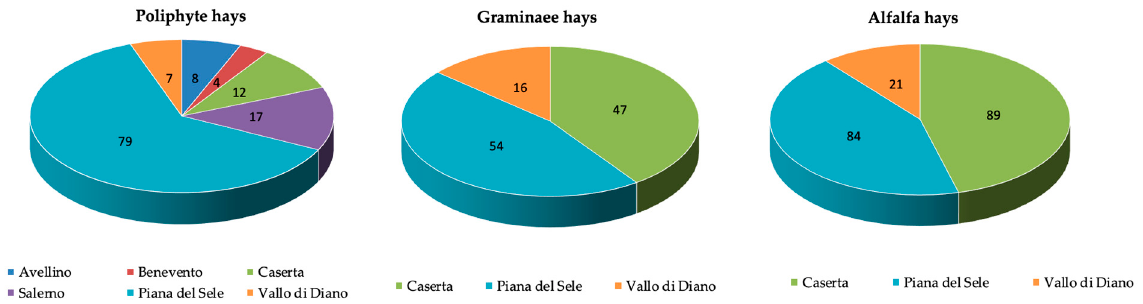
Table 2. NIRS calibration parameters or validations of the method used for forages analysis. Nutrient